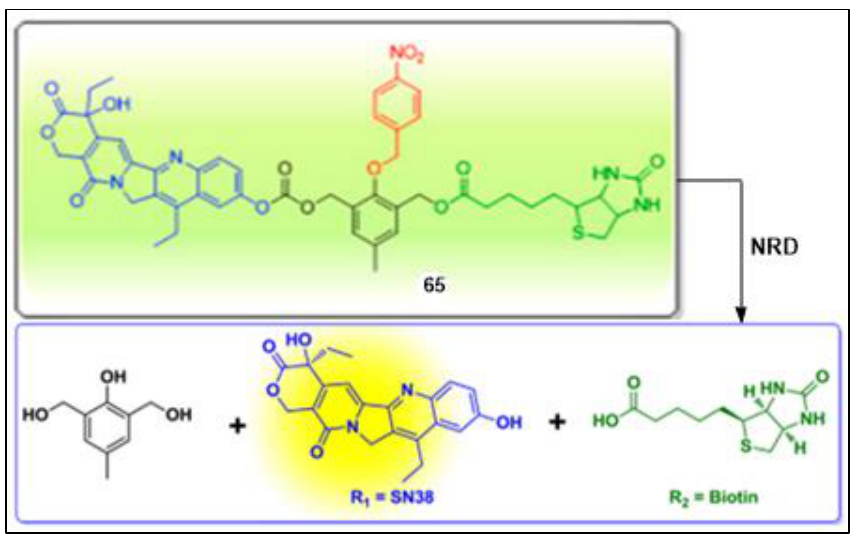
Figure 61. Hypoxia activation of compound 65 . Schematic presentation of drug release in the presence of nitroreductase (NRD) [171].